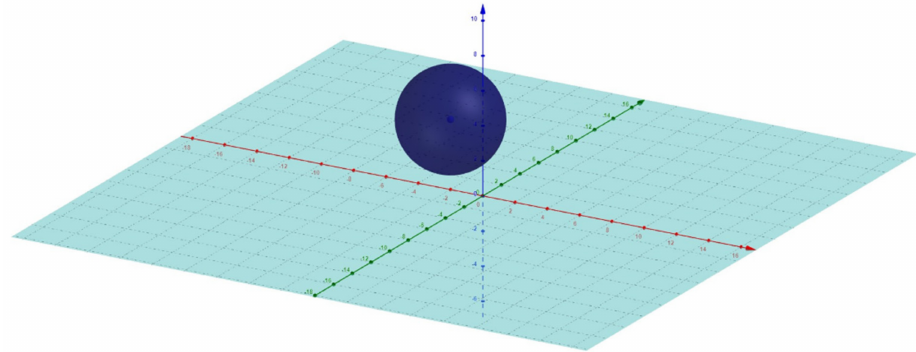
Figure 2. Simplified representation of a contact interaction between a sphere and an infinite plane.